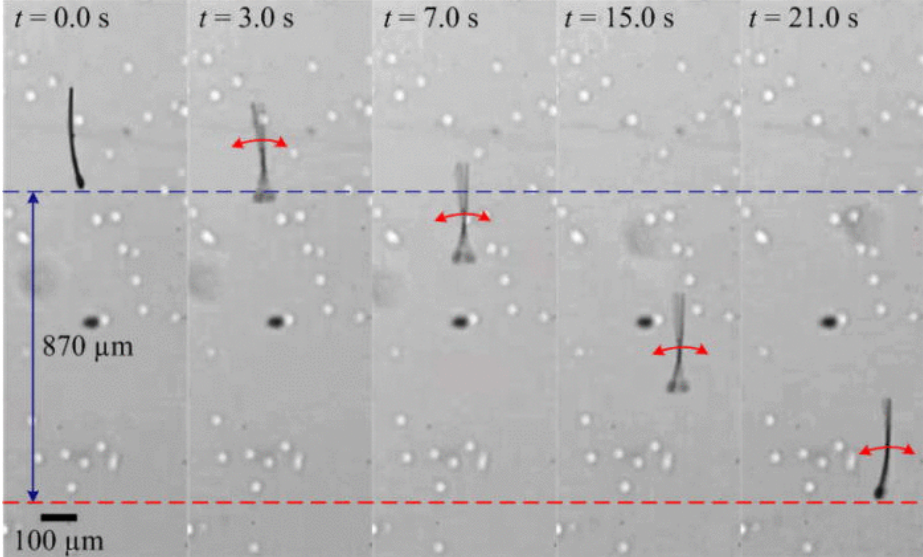
Figure 6. Another kind of Spermbot (MagnetoSperm) moving under the influence of the oscillating (25 Hz) weak magnetic fields (~5 mT). At t = 1 s, oscillating weak magnetic fields are applied which allows MagnetoSperm to swim at a speed of 53 µ m / s. (Reprinted from Reference [28] with permission from AIP Publishing).